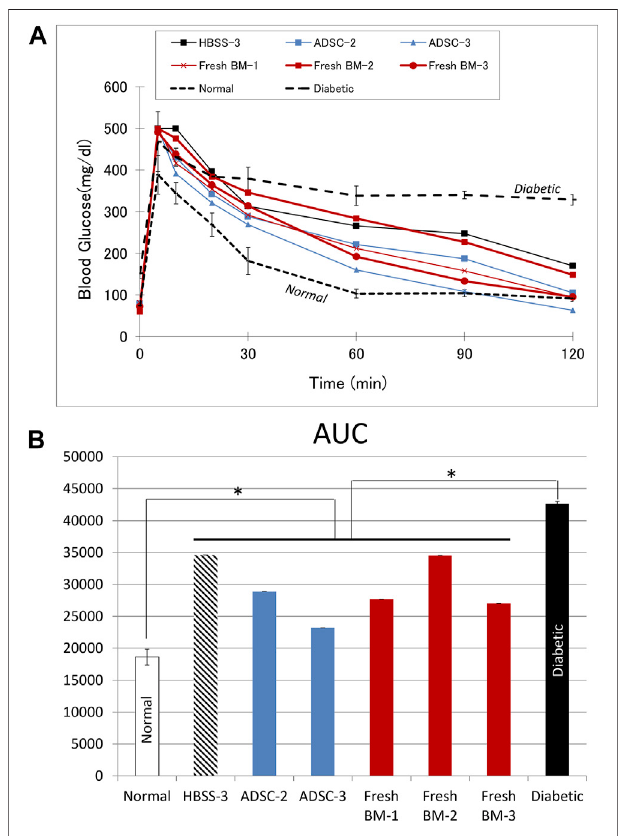
FIGURE 7 | Intravascular glucose tolerance test (IVGTT). (A) The blood glucose curve in animals with improved blood glucose levels. (B) The corresponding area under the curve (AUC). Average data from diabetic ( n (cid:1) 3) or normal ( n (cid:1) 6) Lewis rats are provided for comparison. In comparison todiabetic rats,AUCwassigni fi cantlylower( p (cid:1) 0.002)inthetreatmentgroup with functioning graft, while it was signi fi cantly higher ( p < 0.001) in comparison to values from normal rats.